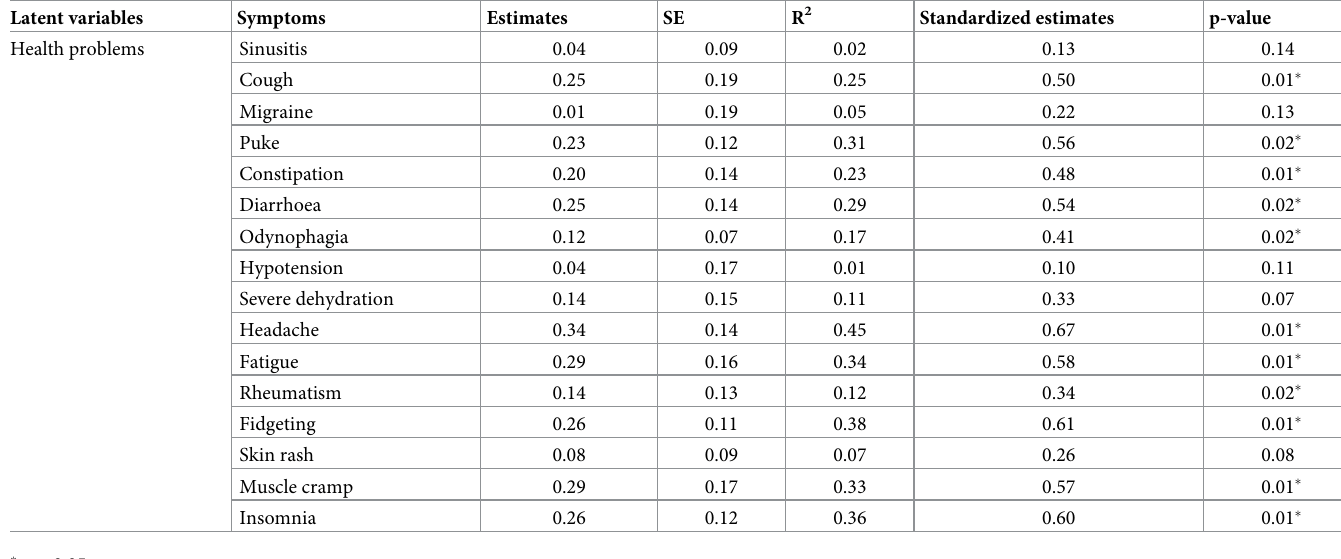
Table 8. The loading factor results derived from latent variables of structural equation modelling. Latent